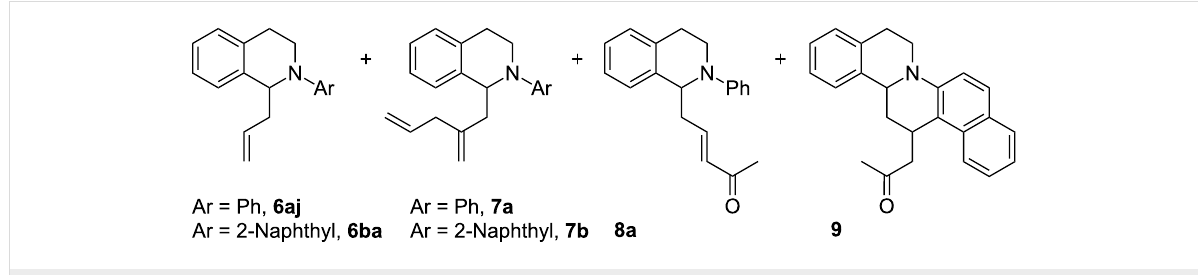
Figure 2: Products from allylzinc reagent addition to 5a and 5b .